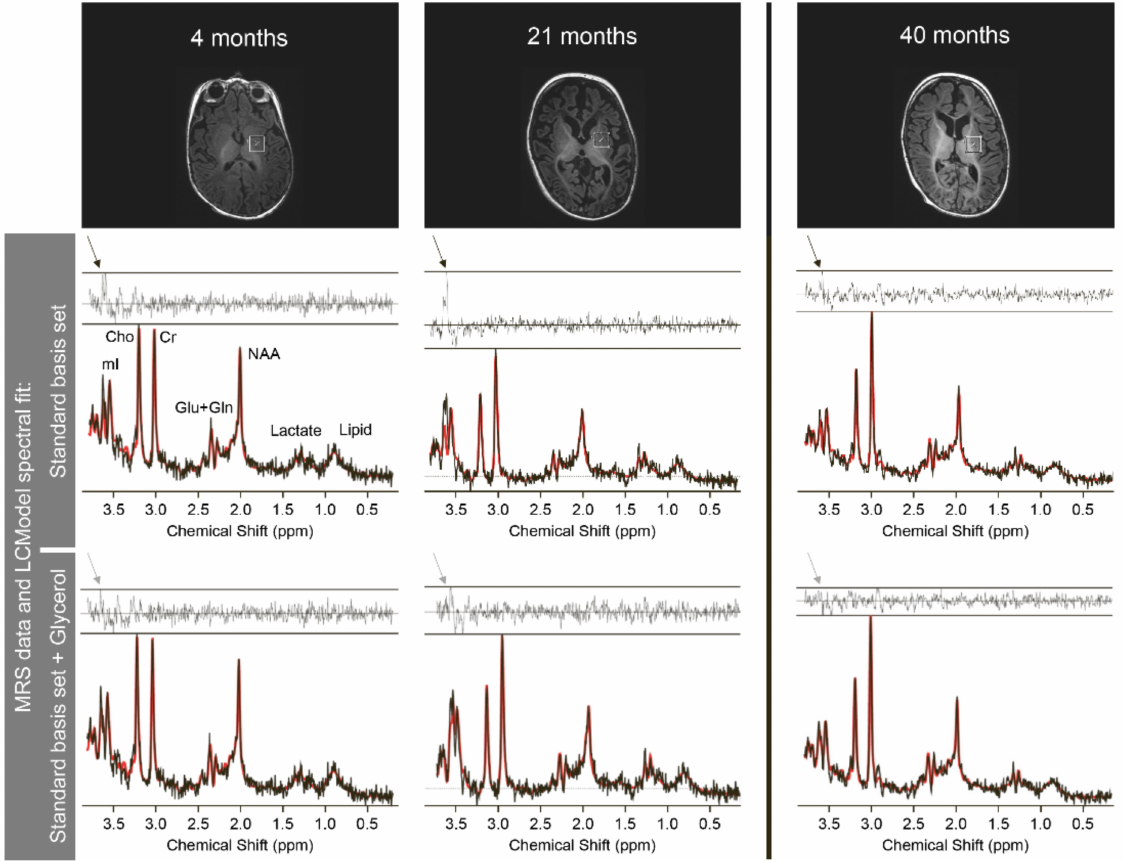
Figure 4. MRS course AGC1-1. Basal ganglia voxel positions and corresponding MR spectra acquired at an age of 3 months (left) and 1 year 9 months (middle), before introduction of classical KD (cKD), and at 3 years 4 months (right), after 18 months on the cKD. MRS data were analysed with LCModel, a fully automated spectral fitting package, which models each in-vivo spectrum as the linear combination of known basis spectra from a standard set of metabolites (see Supplementary Materials for more information). For each spectrum, the raw MRS data are depicted in black and the LCModel fit is overlaid in red. The residuals between the fit and the data are plotted above each spectrum. Using the standard basis set, a peak is seen in the residuals at 3.6–3.65 ppm (black arrows), indicating the presence of a metabolite in the spectrum, which is not included in the basis set. This peak appears most prominent in the spectrum acquired at 1 year 9 months (middle row, middle column), and diminishes in size following introduction of the cKD (middle row, right column). After including glycerol in the LCModel basis set (bottom row), this residual peak decreases in size (grey arrows), and the spectral fit in the area of the spectrum around 3.6 ppm improves, suggesting that glycerol may contribute to this unknown signal. (mI: myo-inositol, Cho: Choline, Cr: Creatine, Glu + Gln: Glutamate + Glutamine, NAA: